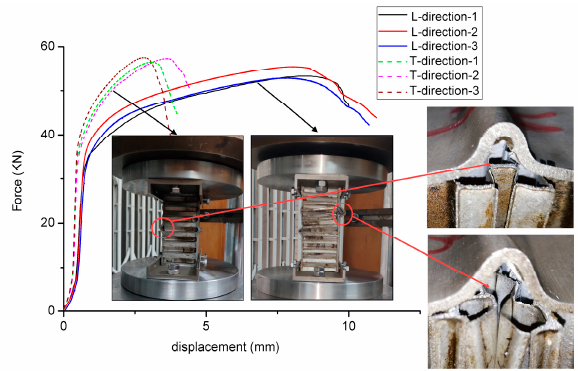
Figure 4. Load–displacement curves and failure modes of the BAHP under in-plane compression.